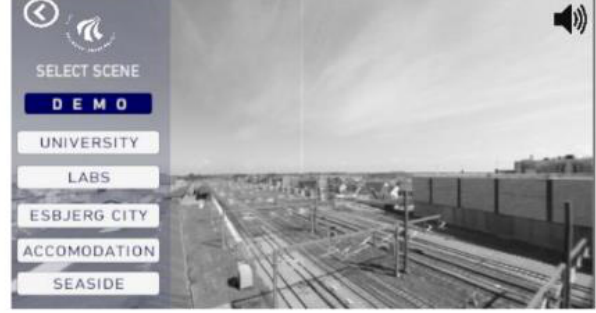
Figure 5. The Mute/Unmute button